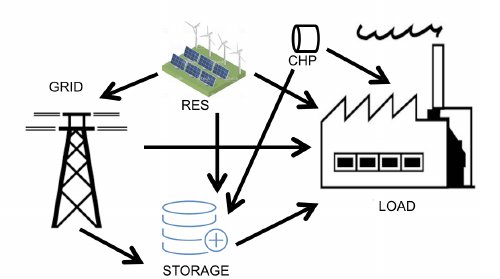
Figure 1. A visual representation of a Virtual Power Plant and its available